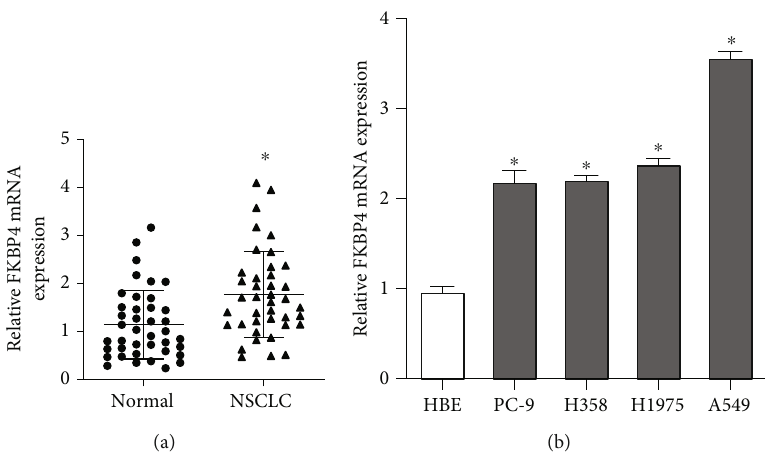
Figure 2: FKBP4 expression in NSCLC tissues and cells: (a) FKBP4 expression in NSCLC tissues, N = 40 ; (b) FKBP4 expression in NSCLC tissues; data were compared using ANOVA followed by the Dunnett t -test, N = 3 ; ∗ P < 0 : 05 vs. normal or HBE. Table 1: Correlation between clinicopathological factors and FKBP4 expression in patients with NSCLC.